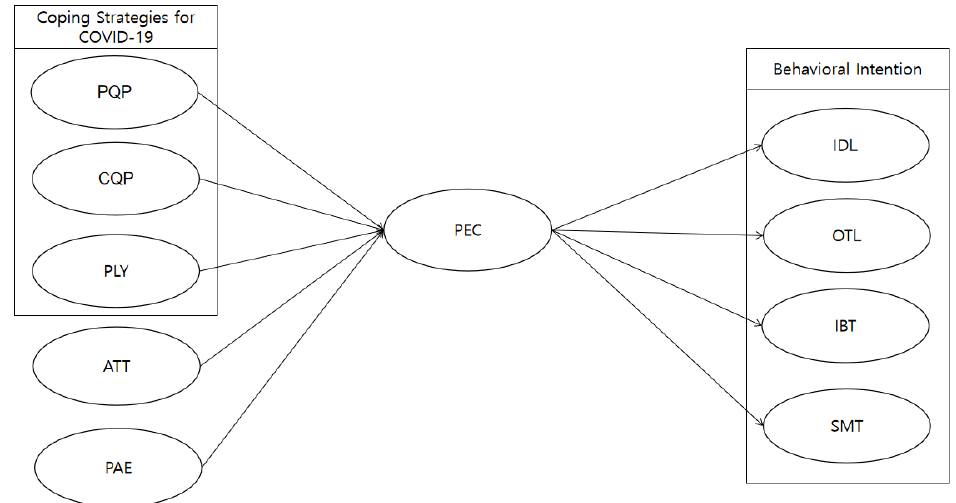
Figure 1. The proposed conceptual model. Note: ATT = Attitude; PAE = Positive Anticipated Emotion; PLY = Policy; PEC = Positive Expectation of COVID-19; BI = Behavioral Intention; PQP = Personal COVID-19 Quarantine Policy; CQP = Company’s COVID-19 Quarantine Policy; IDL = Indoor Leisure; OTL = Outdoor Leisure; IBT = Intra-bound Tourism; SMT = Smart Tourism.